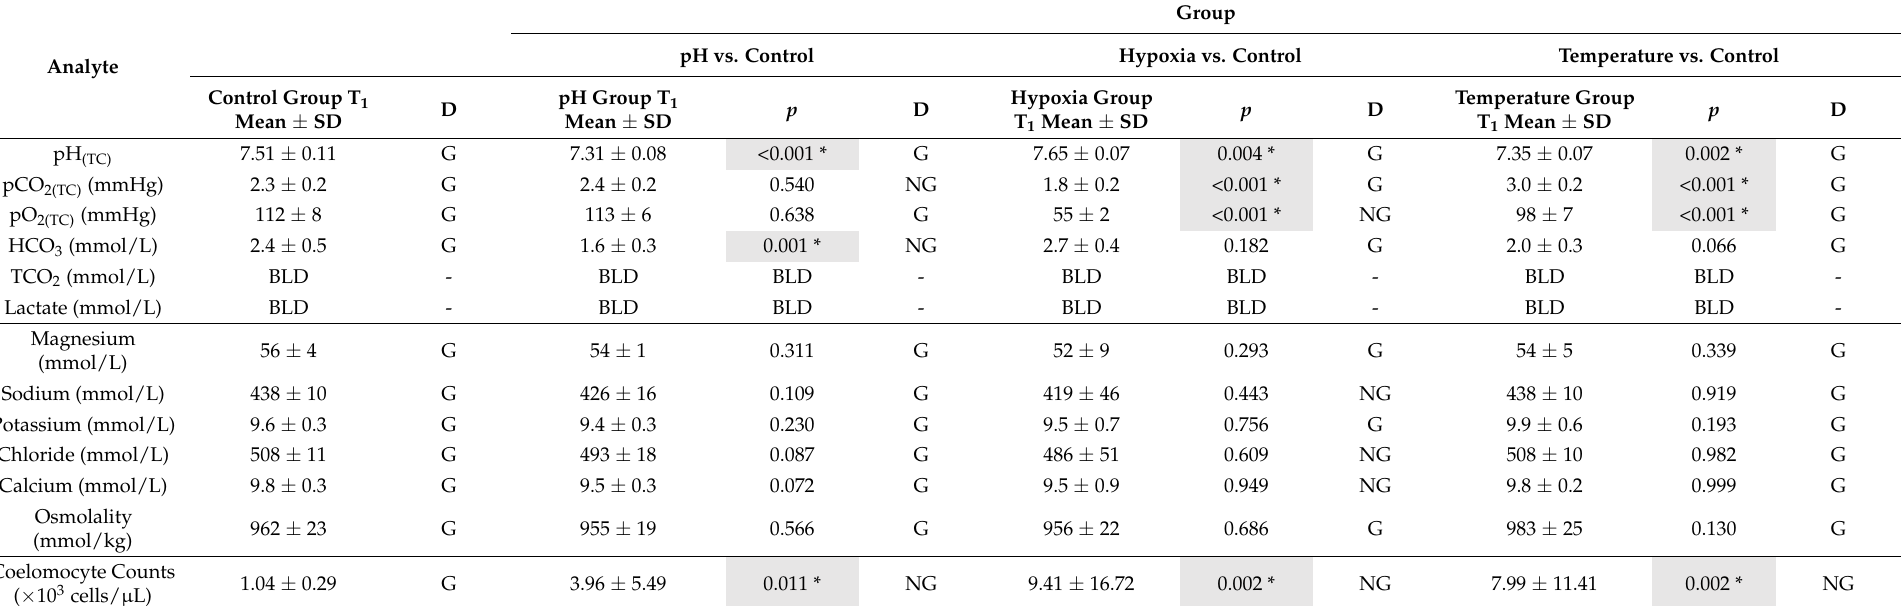
Table 5. Comparison of common sea star ( Asterias rubens ) coelomic fluid blood gases ( n = 10 animals each in pH, temperature and control groups, hypoxia group had 9 animals), electrolytes ( n = 7 animals per group), osmolality ( n = 7 animals per group) and coelomocyte counts ( n = 7 animals per group) between each treatment group versus the control group after 2 weeks of exposure (T 1 ). For analytes where both groups had a Gaussian distribution (G), a Welch’s two sample t-test was used. For analytes where one or both groups had a non-Gaussian distribution (NG), a Wilcoxon rank sum test was performed. Abbreviations: BLD, below limit of detection; D, distribution; TC, temperature correction [40]; TCO 2 , total carbon dioxide. * Denotes statistical significance. Background indicates statistically significant